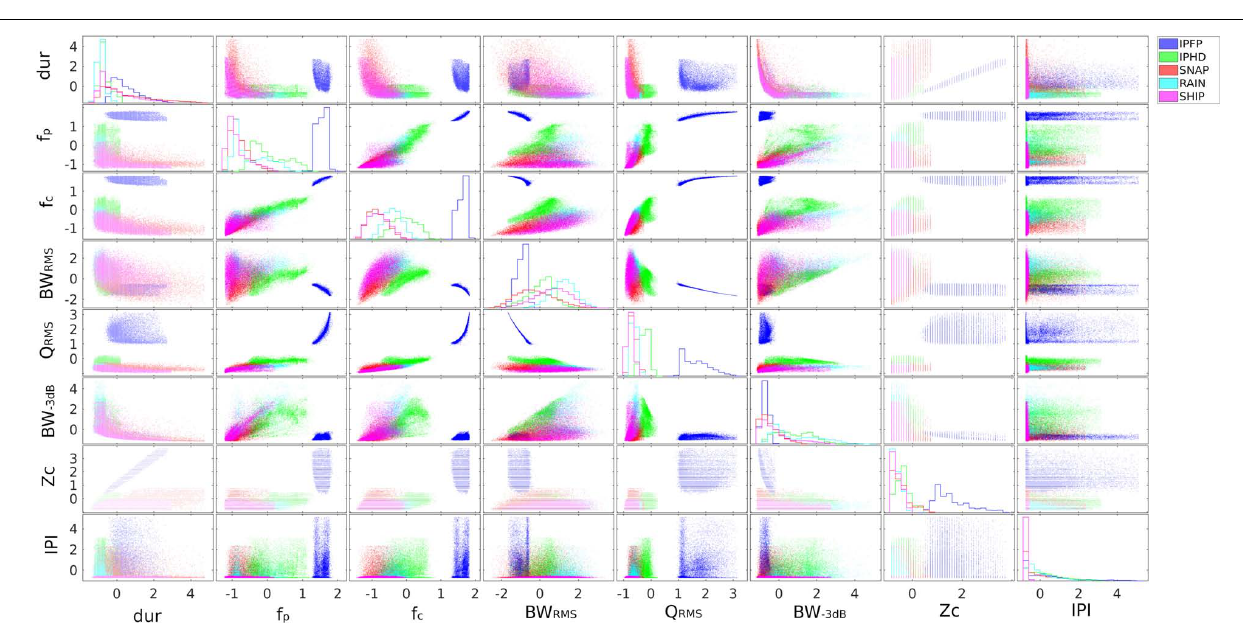
FIGURE 2 | Signal features. Histograms showing the acoustic features measured for the five classes of short-broadband pulses. In blue, echolocation clicks emitted by Indo-Pacific finless porpoise (IPFP). In green, echolocation clicks emitted by Indo-Pacific humpback dolphin (IPHD). In red, pulses emitted by snapping shrimps (SNAP). In cyan, pulses generated by rain (RAIN). In magenta, pulses produced by ship (SHIP).